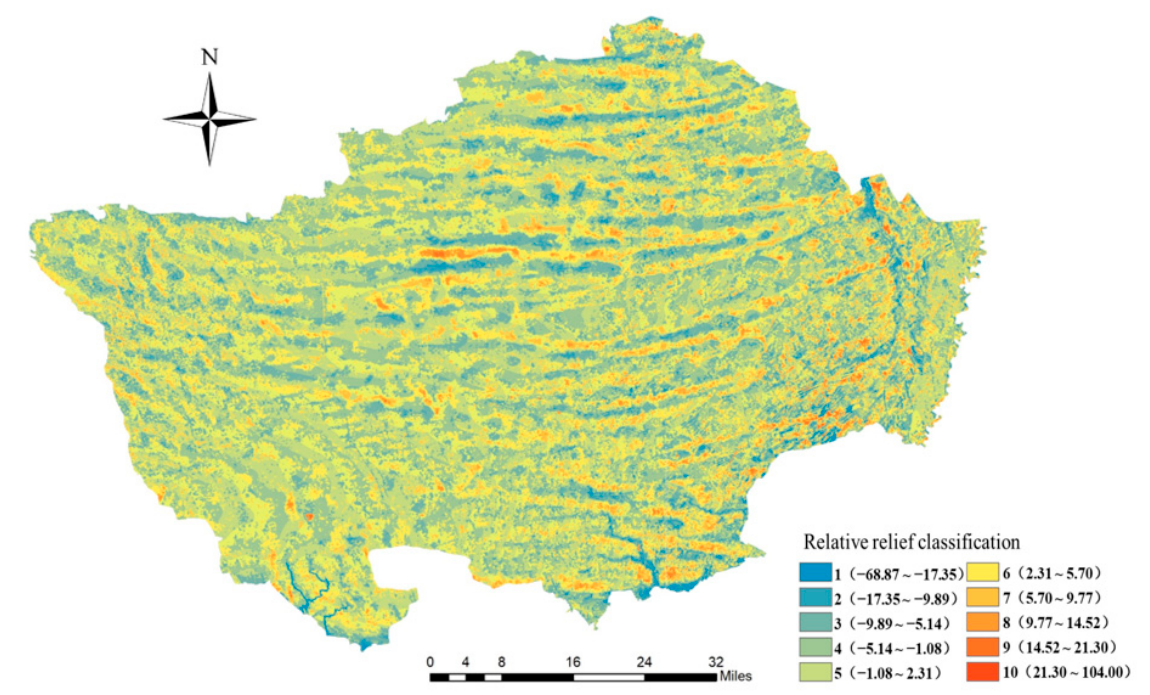
Figure 3. Relief classification map of the study area based on relative topography.